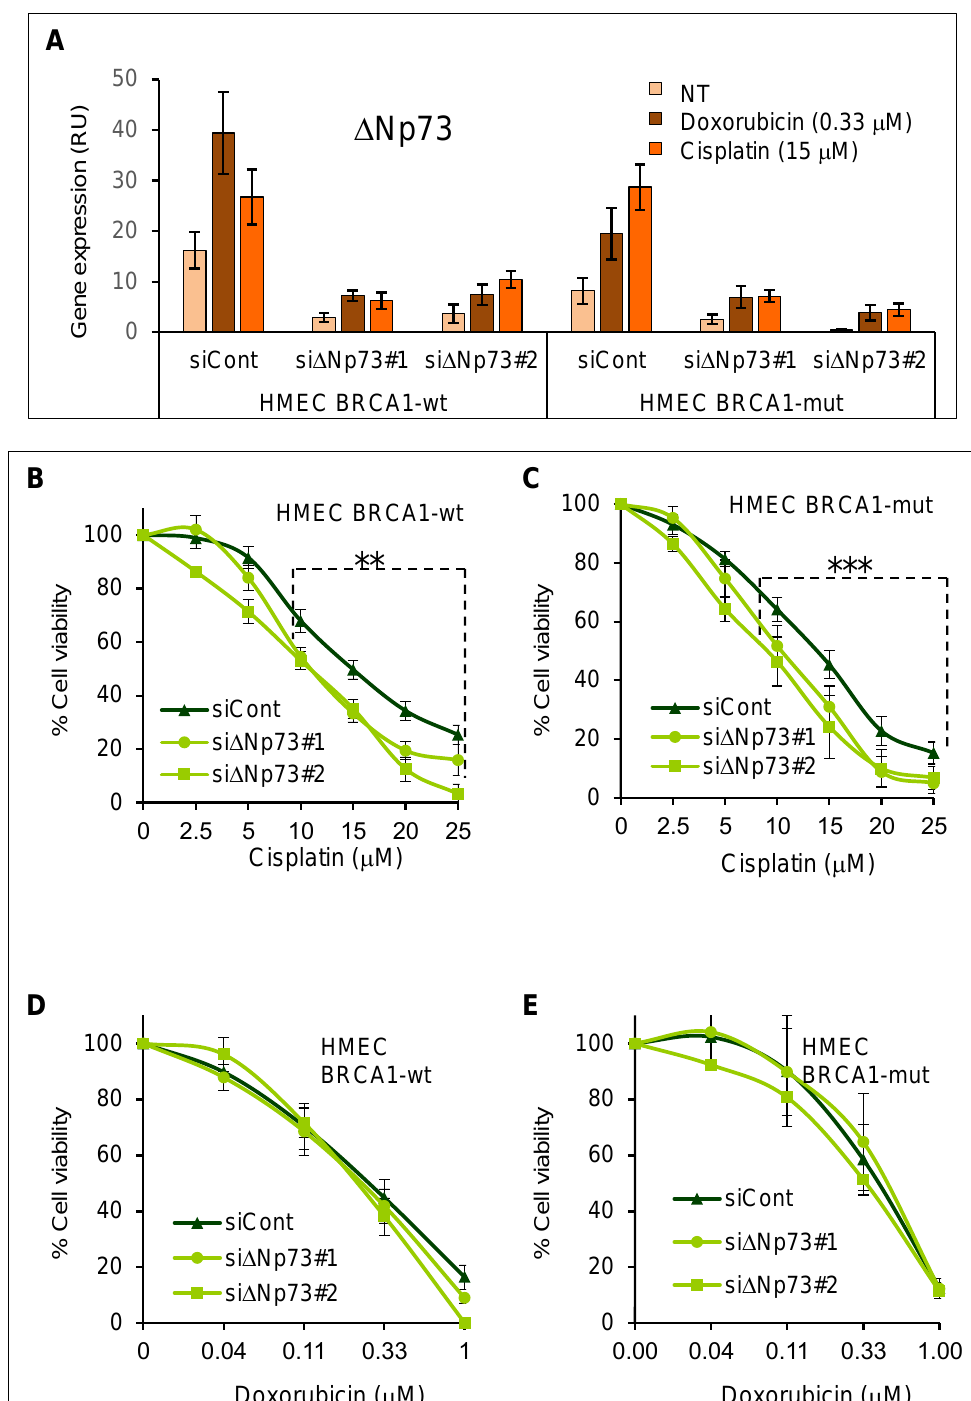
Figure 3. DeltaNp73 protected normal mammary epithelial cells (HMECs) from cisplatin-induced cell death. HMECs from healthy women with wild-type BRCA1 ( BRCA1 -wt, n = 7 individuals) and from BRCA1 mutation carriers ( BRCA1 -mut, n = 5 individuals) were transfected with non-target siRNA (siControl) and with two different siRNAs targeting deltaNp73 (si ∆ Np73#1, n -wt = 7; n -mut = 4 and si ∆ Np73#2, n -wt = 5; n -mut = 4 individuals). Twenty-four hours after transfection the cells were exposed to increasing doses of cisplatin or doxorubicin for 48 h. ( A ) Expression of deltaNp73 (mRNA) following induction with DNA damage and inhibition by siRNA. Data of RT-qPCR were normalized to GAPDH (RU = 2 D CT x 10 4 ). ( B–E ) Cell viability was measured by tetrazolium salt (XTT)-based